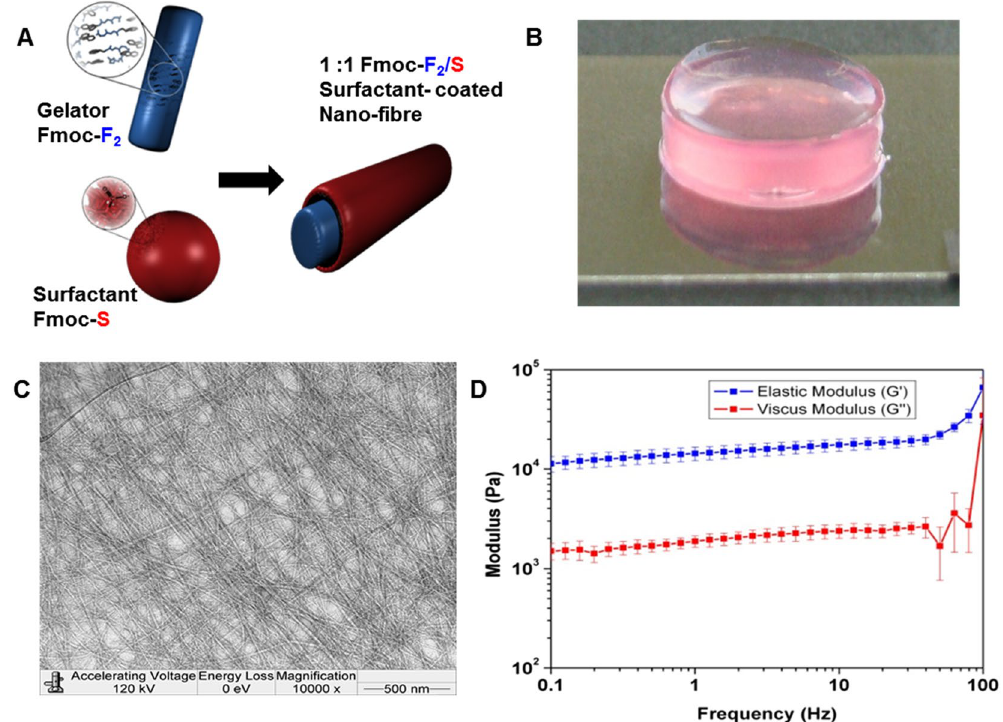
Figure 1. Self-assembly of two-component gelators. ( A ) Schematic presentations of the building blocks, gelator Fmoc-F 2 , surfactant Fmoc-S and surfactant coated nano fiber Fmoc-F 2 /S. ( B ) Macroscopic image for gel in culture media. ( C ) TEM image of hydrogel showing fibrous morphology. ( D ) Oscillatory rheology of the gels showing elastic moduli of 15.5